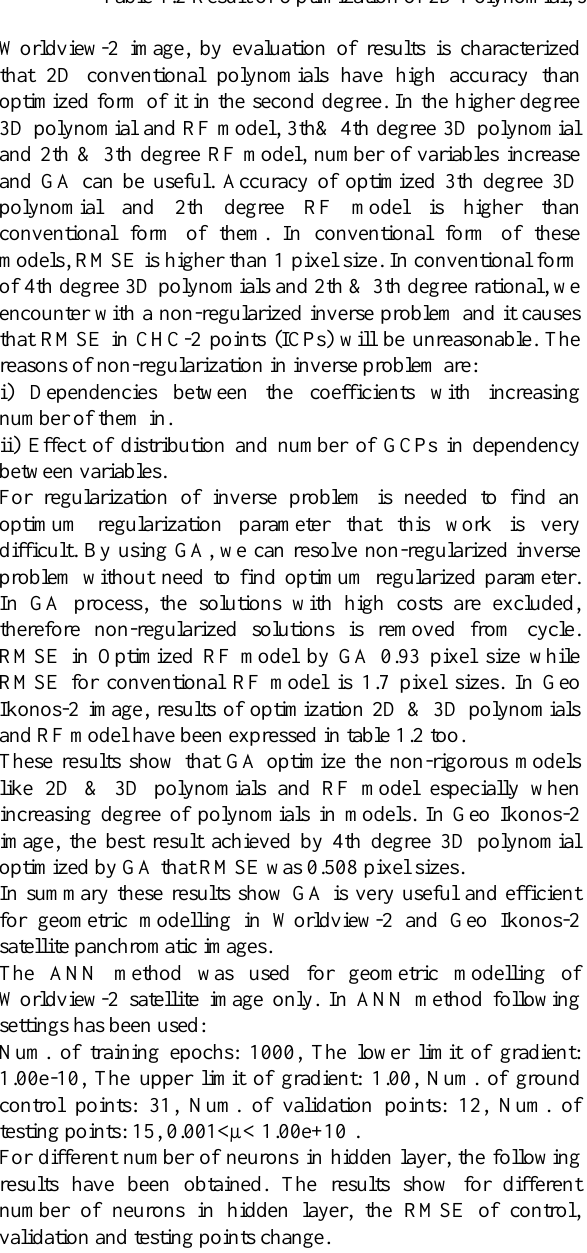
Table 1.2 Result of Optimization of 2D Polynomial, 3D Polynomial, RF model by GA for Geo Ikonos-2 image